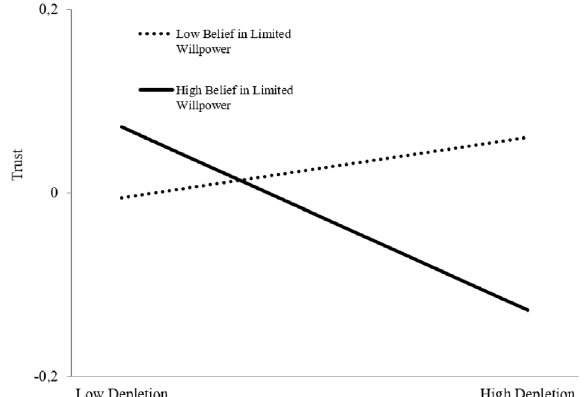
Figure 3. Cross-level interaction of leaders’ trait belief in limited willpower and leader depletion predicting leaders’ trust beliefs (Study 3). Note The relationship between leaders’ feelings of depletion and leaders’ trust in their employees was significant ( Est. = − .17, SE = .06, p = .006) at high levels of belief in limited willpower, but not significant ( Est. = .07, SE = .05, p = .183) at low levels of belief in limited